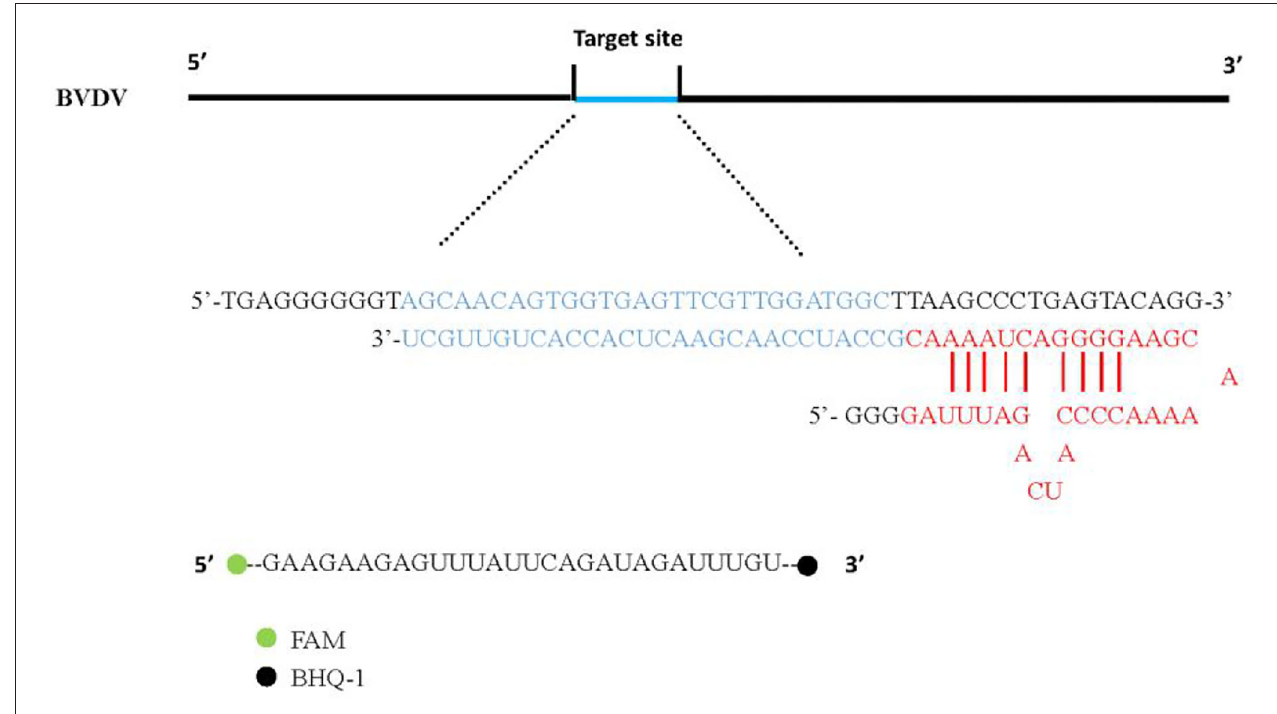
FIGURE 1 | CrRNA and Reporter pattern model. The hairpin structure at the 5’ end of crRNA was recognized by the REC (crRNA recognition) lobe of Cas13a protein. Cas13a produces RNase activity in the presence of target RNA and releases fluorescent